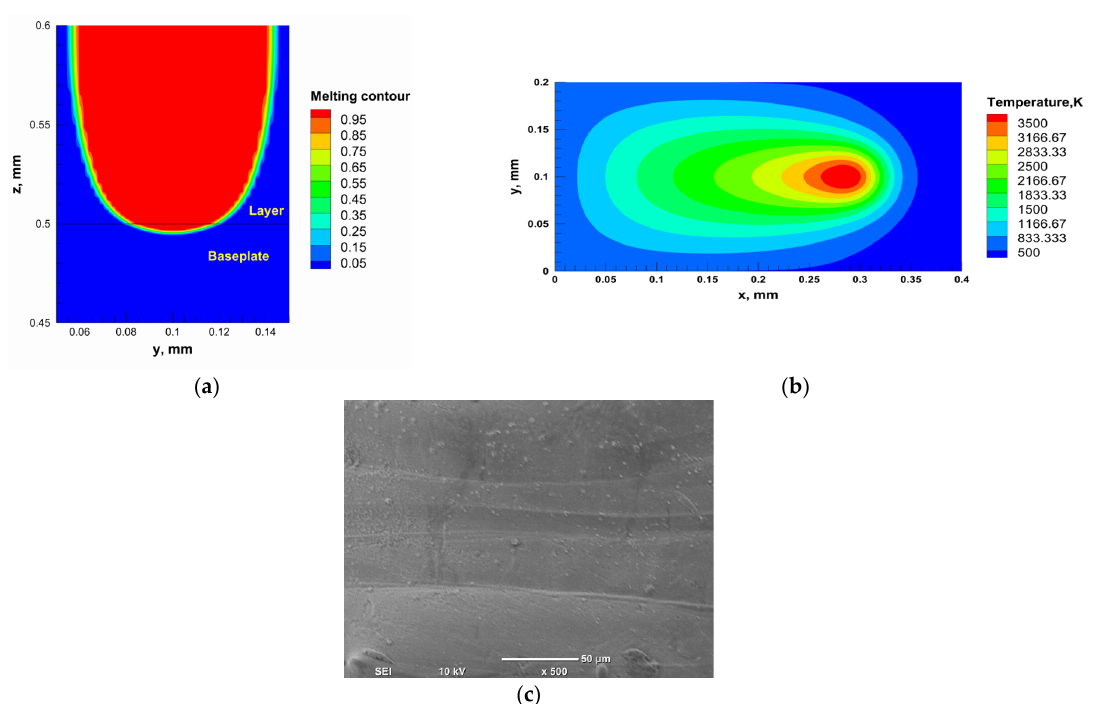
Figure 10 . ( a ) The melting contour for the vertical section of the scanning path, ( b ) the temperature distribution for the layer top surface, ( c ) the SEM image of top layer surface.